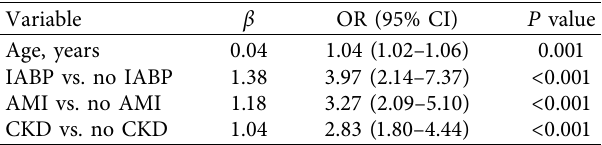
Table 3: Multivariable logistic regression analysis of